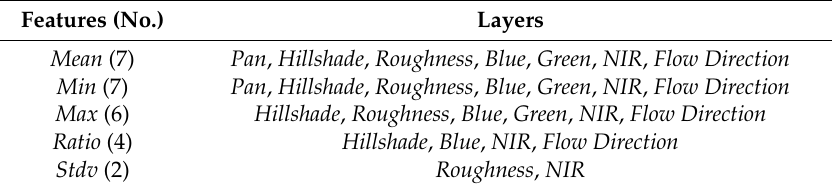
Table 3. Selected features used in this